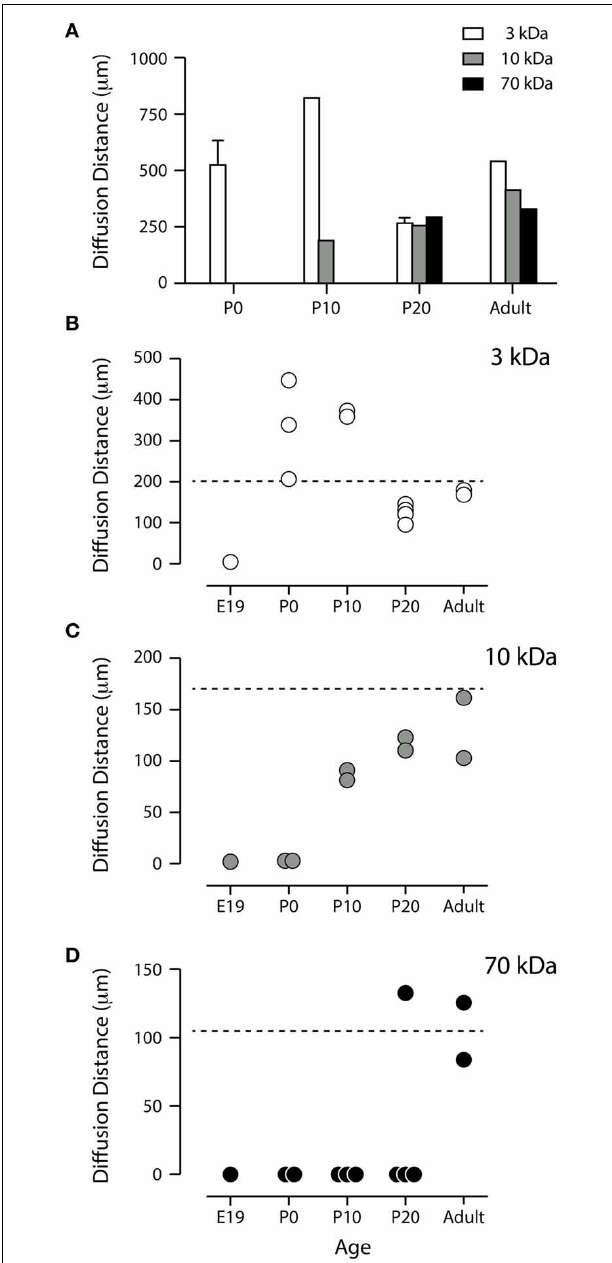
FIGURE 4 | (A) Apparent diffusion distance for three different sized biotinylated dextrans. The values were obtained by measuring the distance to which each marker penetrated into the dorso-lateral wall of the lateral ventricle after injections were made in the contralateral side. Mean ± SEM (only if n > 2), values from individual experiments are illustrated as circles in (B–D) . P, postnatal day. Note that none of the dextrans penetrated at E19 (see B–D and Figure 3 ). (B,C) Standardized apparent diffusion distances compared to theoretical values. Apparent diffusion distances were standardized by estimating the apparent diffusion distance at 1min after intraventricular injection of each dextran at each age using Fick’s second